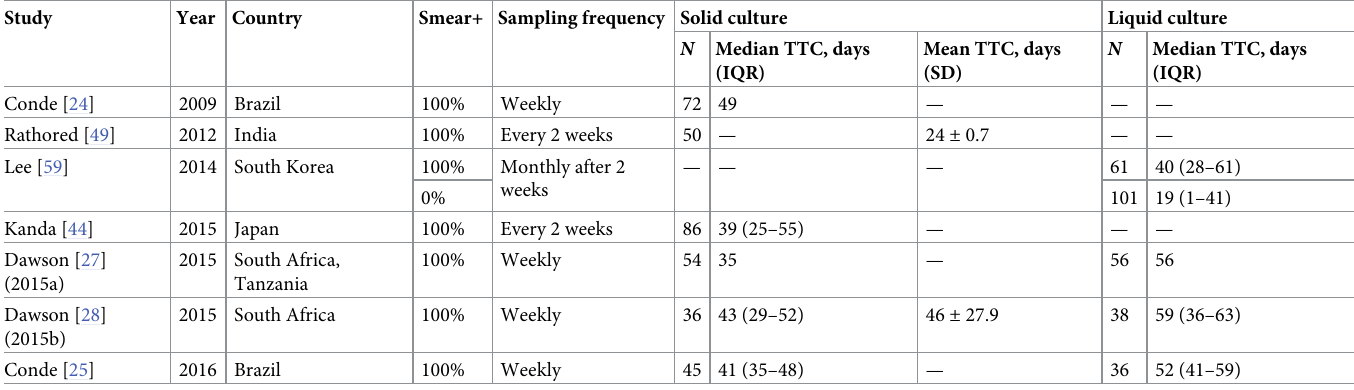
Table 5. Studies reporting a summary measure of time to solid or liquid culture conversion � AU : ThemeasureofspreadgivenformeanTTCwaslabeledSDinbothcases ; soIdeletedSEfromthecolumnheadandabbreviationslist : Pleaseconfirmthatthisiscorrect : .